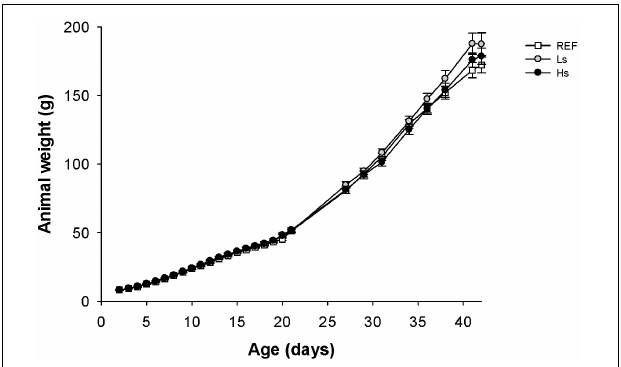
FIGURE 1 | Body weight (g) of suckling rats during the study (from days 2 to 42 of life). Results are expressed as mean ± SEM ( n = 24